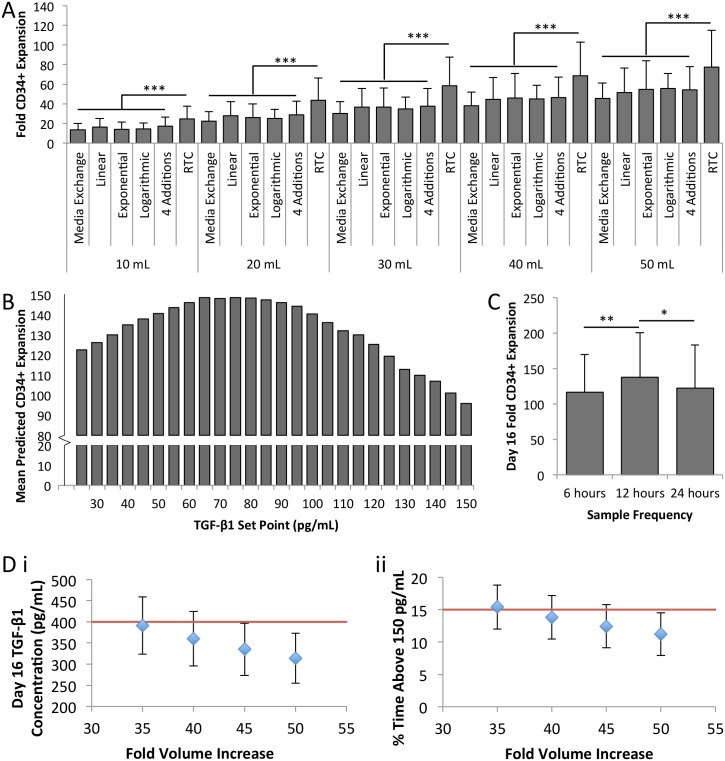
Model predicts a PID controller is the optimal media delivery method.
[A] Different feeding strategies were investigated in silico. When normalized to day 16 total media requirements, a simple algorithm (RTC) significantly outperforms other media delivery strategies for CD34+ expansion (n = 100). [B] The PID controller performs optimally at a set point of 85 pg/mL for any fold volume increase (n = 100). [C] CD34+ expansion is improved using 12 hour sampling over 6 hour or 24 hour sampling (n = 100). [D] A 50-fold volume increase using the PID controller is the minimum fold volume increase to meet both concentration constraints (<400 pg/mL TGF-β1 on day 16 and <15% of time above 150 pg/mL) (n = 100). * p<0.05, ** p<0.01, *** p<0.001.